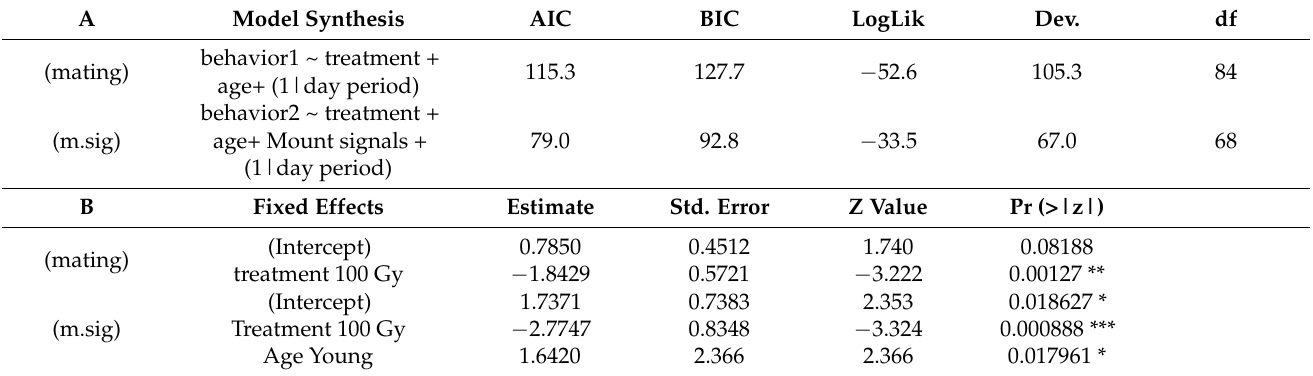
Table 1. Results of generalized linear mixed-effects model (GLMM) for mating and mount signals (m.sig). (A) The best explanatory model for each dependent variable. (B) The significant independent variables of the chosen models. Dev (deviance), Est (estimate), df (df residuals). * p < 0.05, ** p < 0.01, *** p < 0.001.